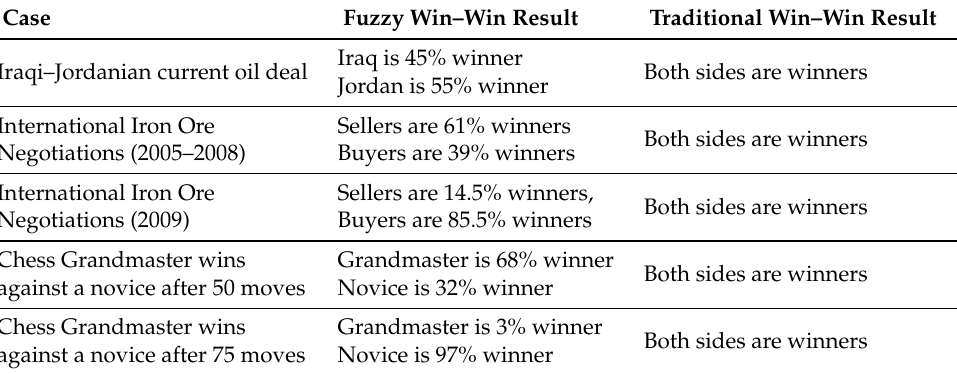
Table 5. Comparison results of the fuzzy win–win model to the traditional win–win approach. Case Fuzzy Win–Win Result Traditional Win–Win Result Both sides are